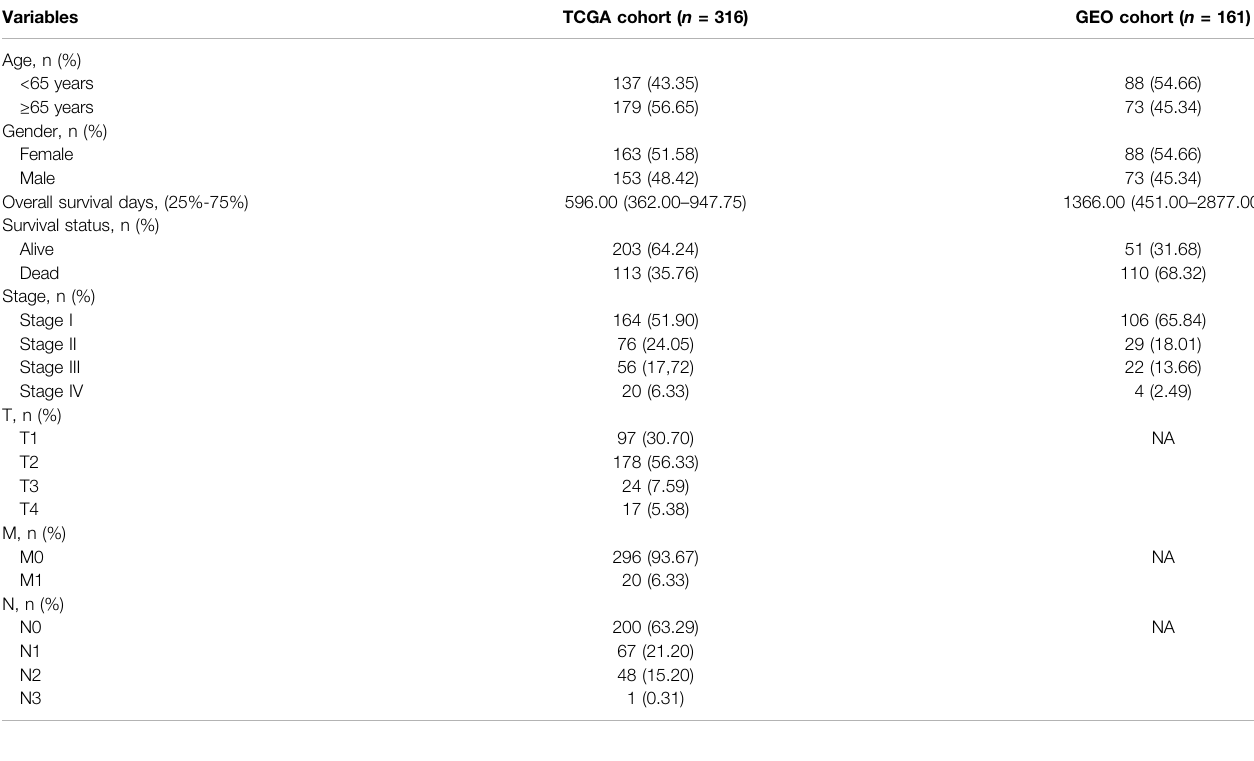
TABLE 1 | Clinical characteristics of the NSCLC patients used in this study.